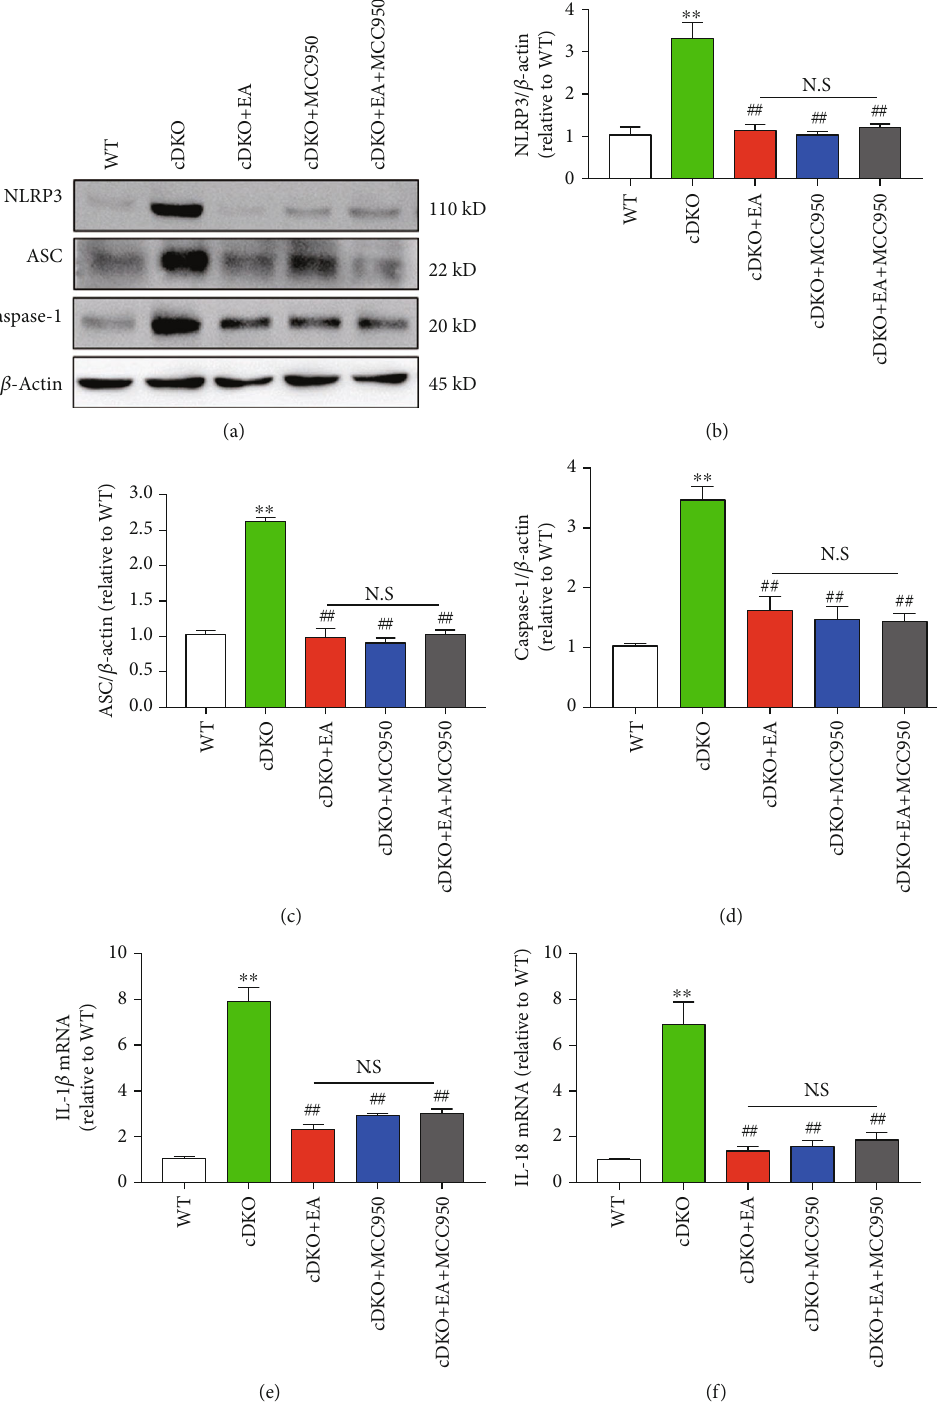
Figure 5: MCC950 does not further increase the e ff ect of EA on inhibiting NLRP3 in fl ammasome and neuroin fl ammatory responses in the hippocampus of PS cDKO mice. (a) Representative Western blot of NLRP3, ASC, and caspase-1 in the hippocampus. (b) – (d) Quantitative analysis of NLRP3, ASC, and caspase-1 in the hippocampus were standardized based on the respective level of β -actin ( n = 6 mice for each group). (e, f) Total RNA was isolated and subjected to quantitate the mRNA levels of IL-1 β and IL-18 in the hippocampus by qRT- PCR ( n = 5 mice for each group). The mRNA levels were standardized based on the respective level of β -actin. Values were expressed as relative changes to WT mice, which was set to 1.0. Data are the mean ± S : E : M : , ∗ p < 0 : 05 , ∗∗ p < 0 : 01 vs WT mice. # p < 0 : 05 , ## p < 0 : 01 vs cDKO